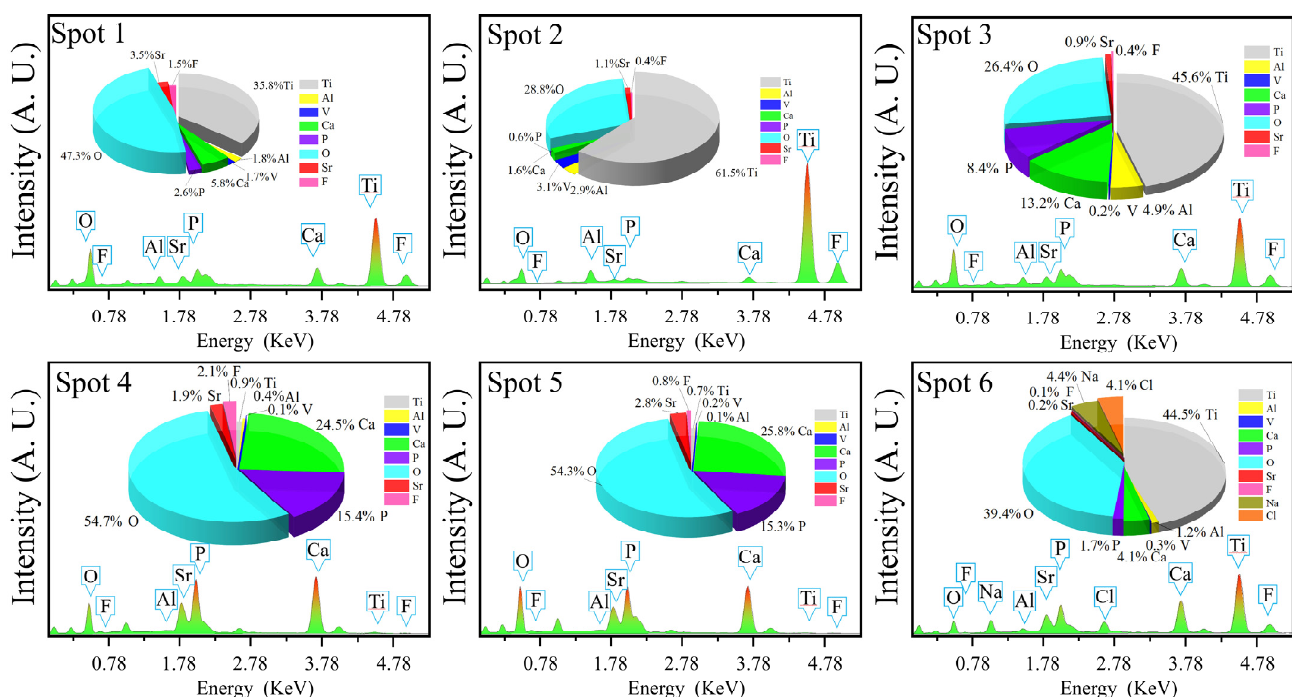
Figure 4. EDS analyses of the deposition products (D30–D70).